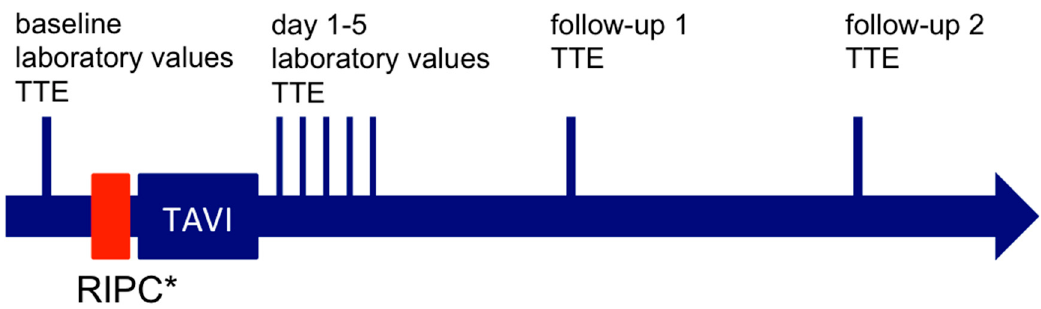
Figure 3. Timeline of events. * RIPC group only. RIPC = remote ischemic preconditioning; TAVI = transcatheter aortic valve implantation; TTE = transthoracic echocardiography.